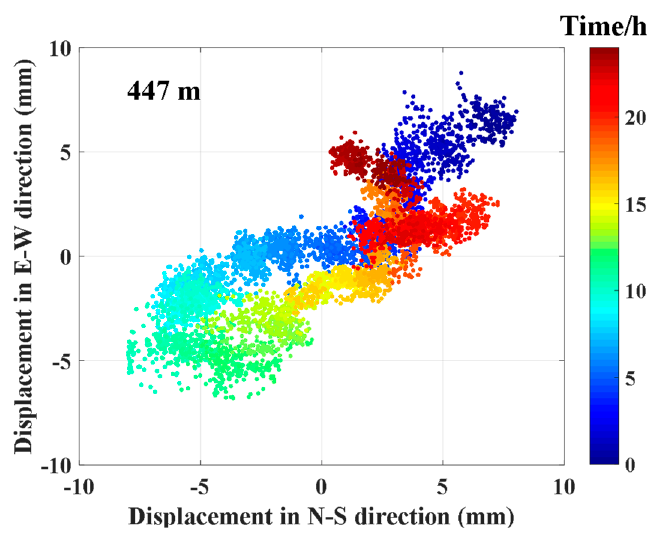
Figure 11. Displacement trajectory of the roof (from 00:00 to 24:00 on 6 July 2017).